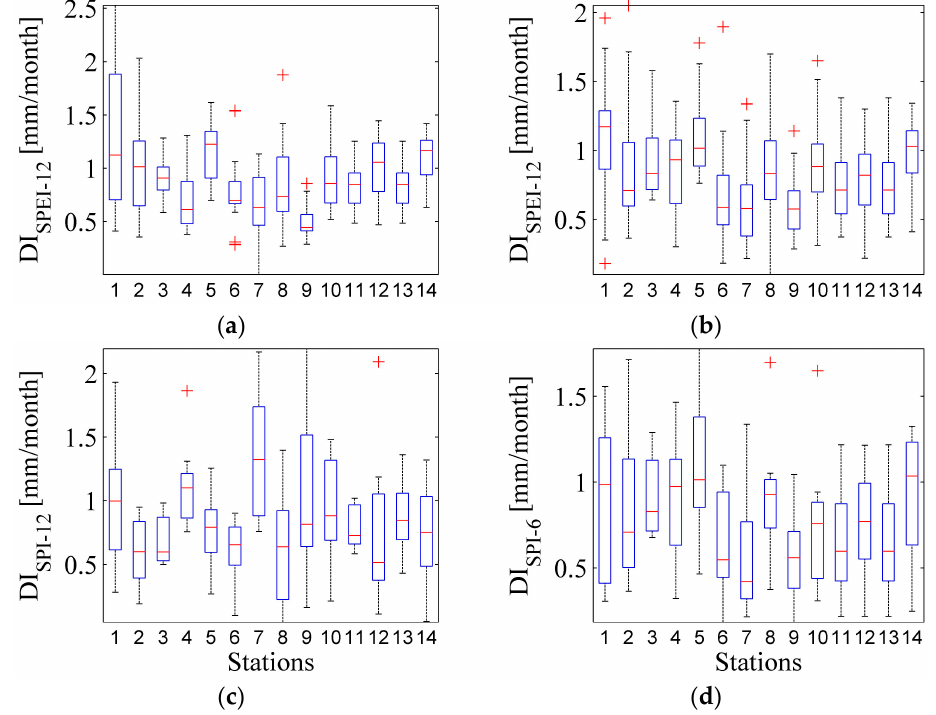
Figure 5. Drought Intensity (DI) across the Free State and North West Provinces. ( a ) Drought intensity computed using SPEI 12 values; ( b ) drought intensity computed using SPEI 6 values; ( c ) drought intensity computed using SPI 12 values and ( d ) drought intensity computed using SPI 6 values.